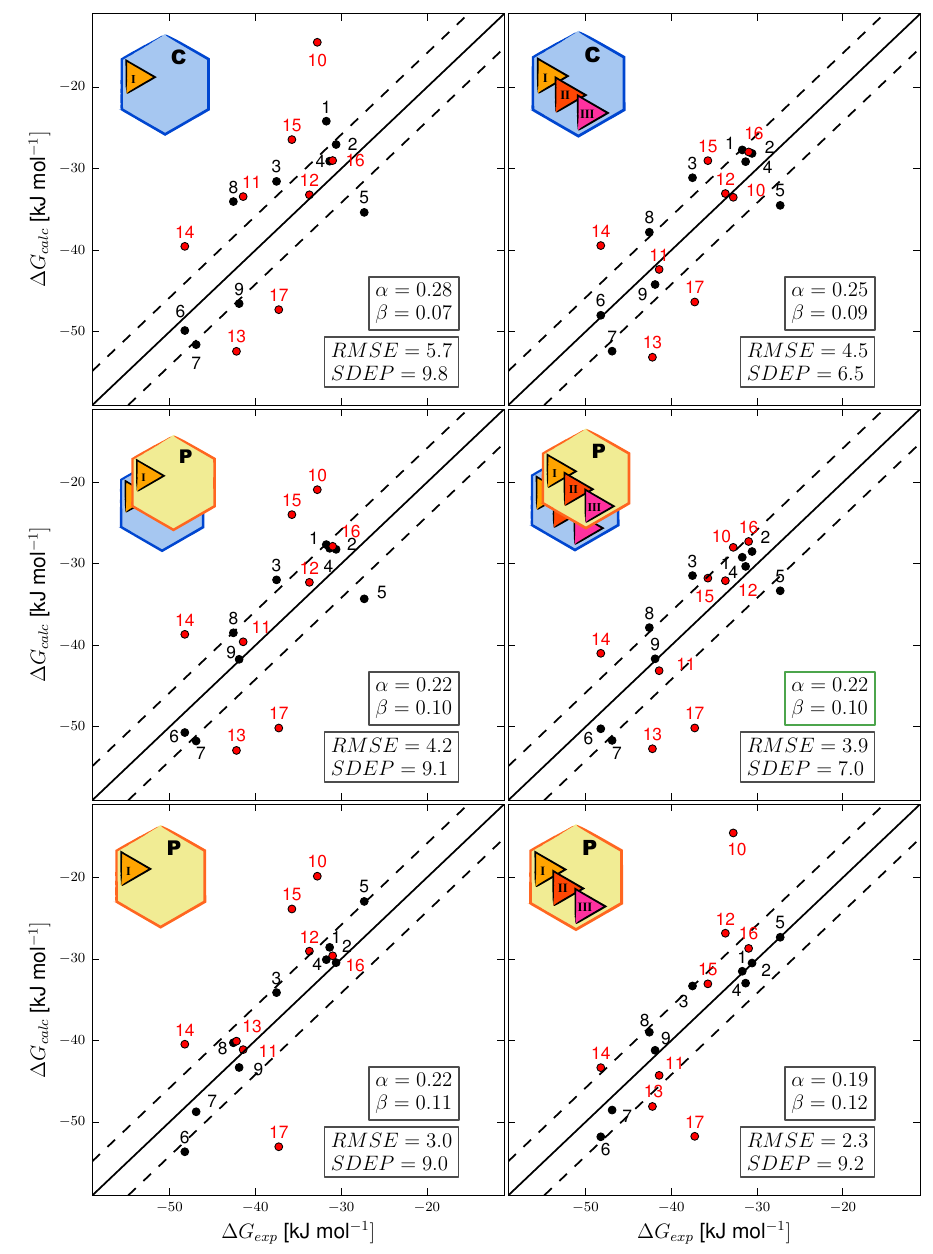
Figure 3. Correlations obtained using different CYP 2D6 LIE models for prediction of aryloxypropanolamine binding affinities, between the experimental ( ∆ G ) and predicted exp free energy of binding (∆ G ) . Ideal correlation is indicated by the solid line, the dashed calc 1 (4.184 kJ mol 1 ). lines represent deviations from experiment of 1 kcal mol − −